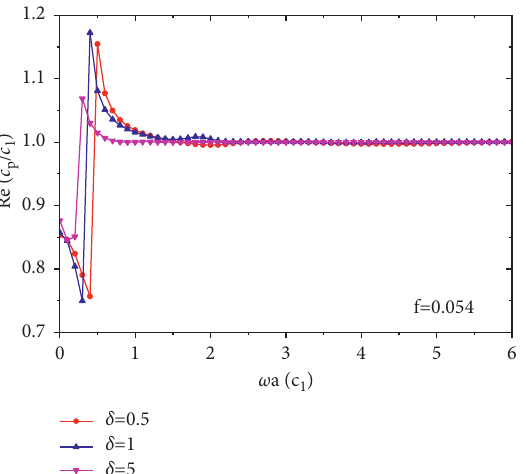
Figure 7: Comparison of ratios of the phase velocity in the composite material and matrix obtained by the differential method when quasi-P wave propagates in the composite material for inclusion volume fraction of 5.4% and δ � 0 . 5, 1, and 5,